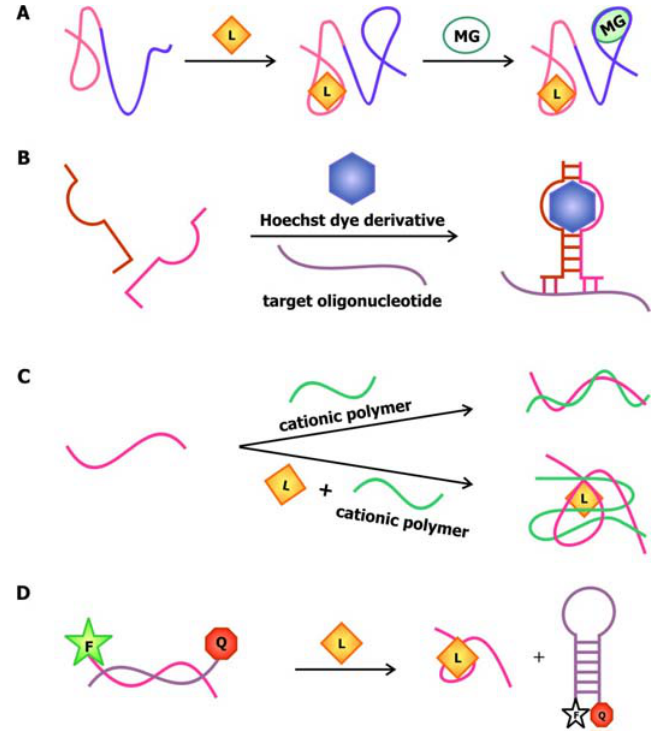
Figure 4. Designs of other optical biosensors. a) The modular aptamer sensor in which the analyte sensing aptamer is linked to a malachite green (MG) binding aptamer, which